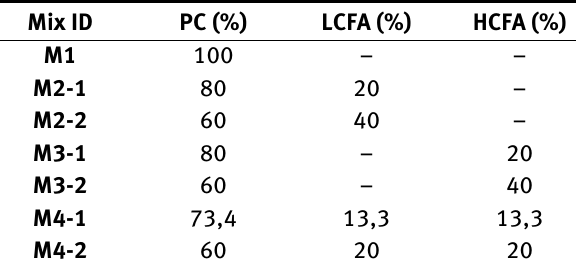
Table 2: Blends prepared to evaluate sulphate resistance.